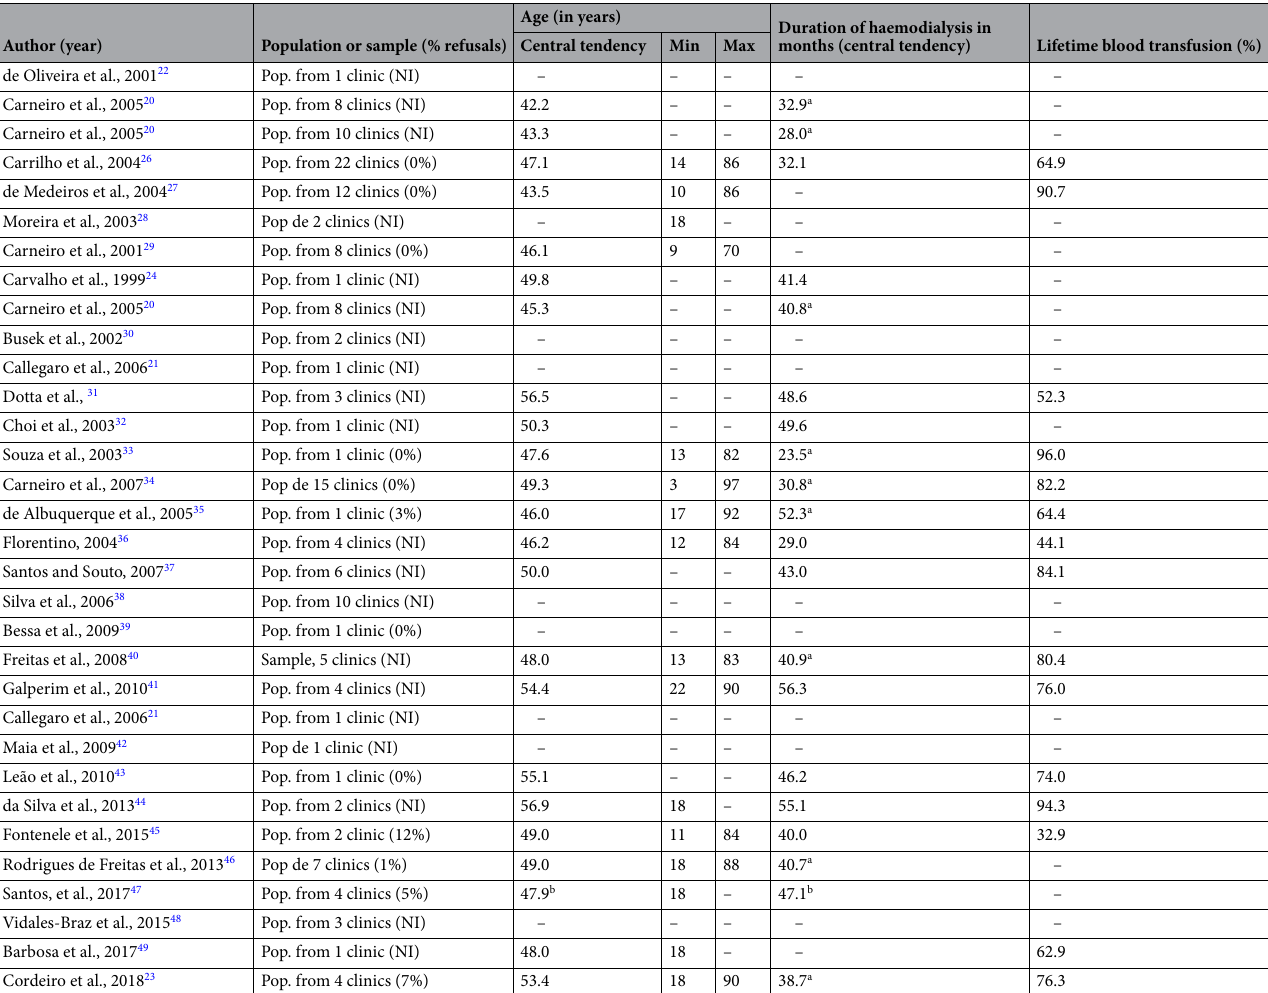
Table 2. Characteristics of study populations in articles selected to estimate prevalence rates of HCV infection in haemodialysis patients in Brazil. NI not informed, a median calculated via linear interpolation of accumulated distribution of time in dialysis; b weighted mean of